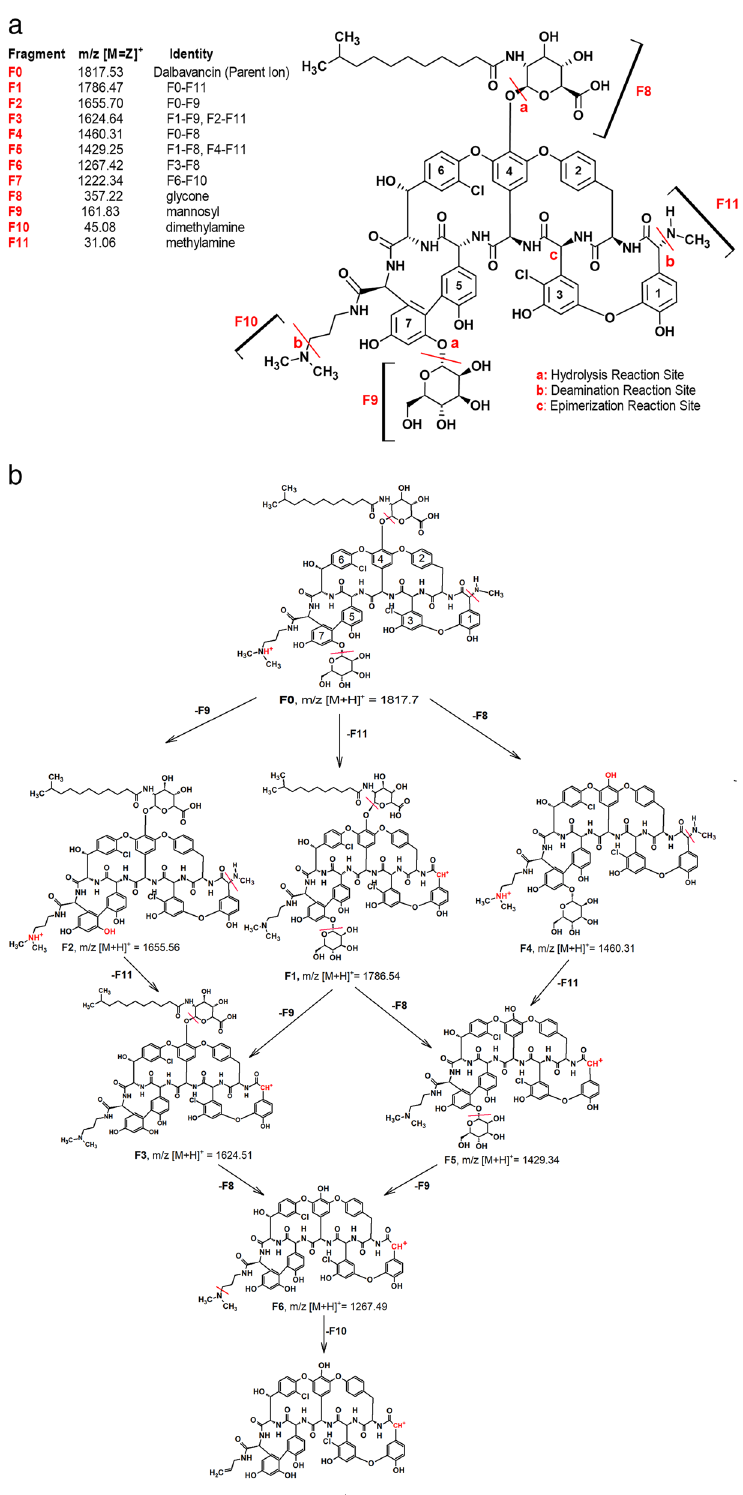
Fig. 6 a Cleavage/reaction sites on dalbavancin and secondary fragments observed by MS/MS; numbering of the aromatic rings as assigned in Zhu et al. (2020). b Structures and fragmentation pattern of secondary